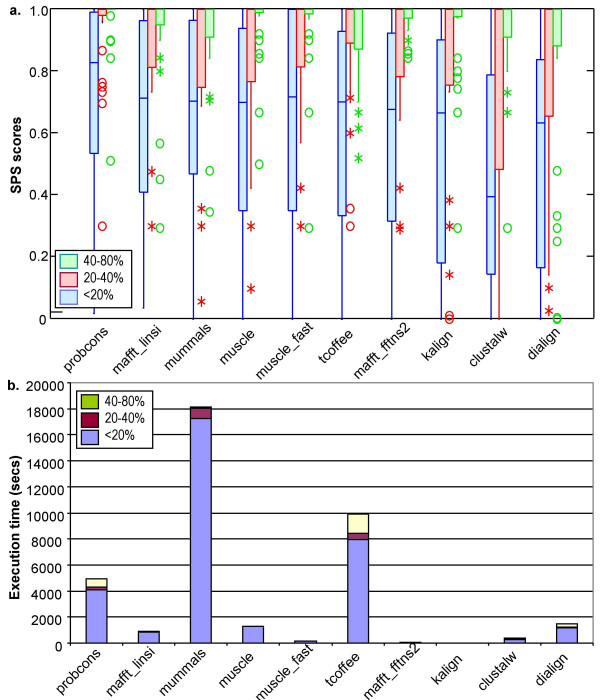
Program SPS scores at different levels of overall sequence similarity. a) Box plots of the SPS scores obtained by the different alignment programs in subset 1, showing the extreme observations (stars or circles), lower quartile, median, upper quartile, and largest observation in each similarity category. b) Execution times in seconds required to construct all the multiple alignments in Subset 1. Programs are displayed in the order of the Friedman test using the SPS scores for group V11 (additional file 1), with the highest scoring program on the left.